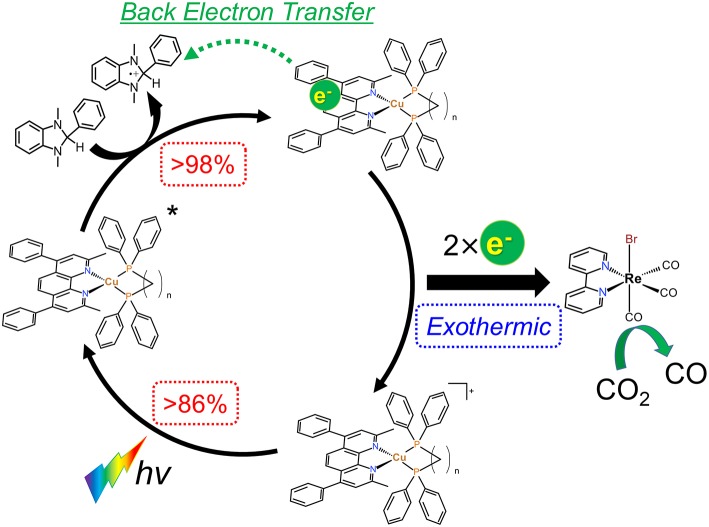
Expected reaction mechanism of the CO2 reduction using the Cu(I) complexes, Re(bpy) and BIH.